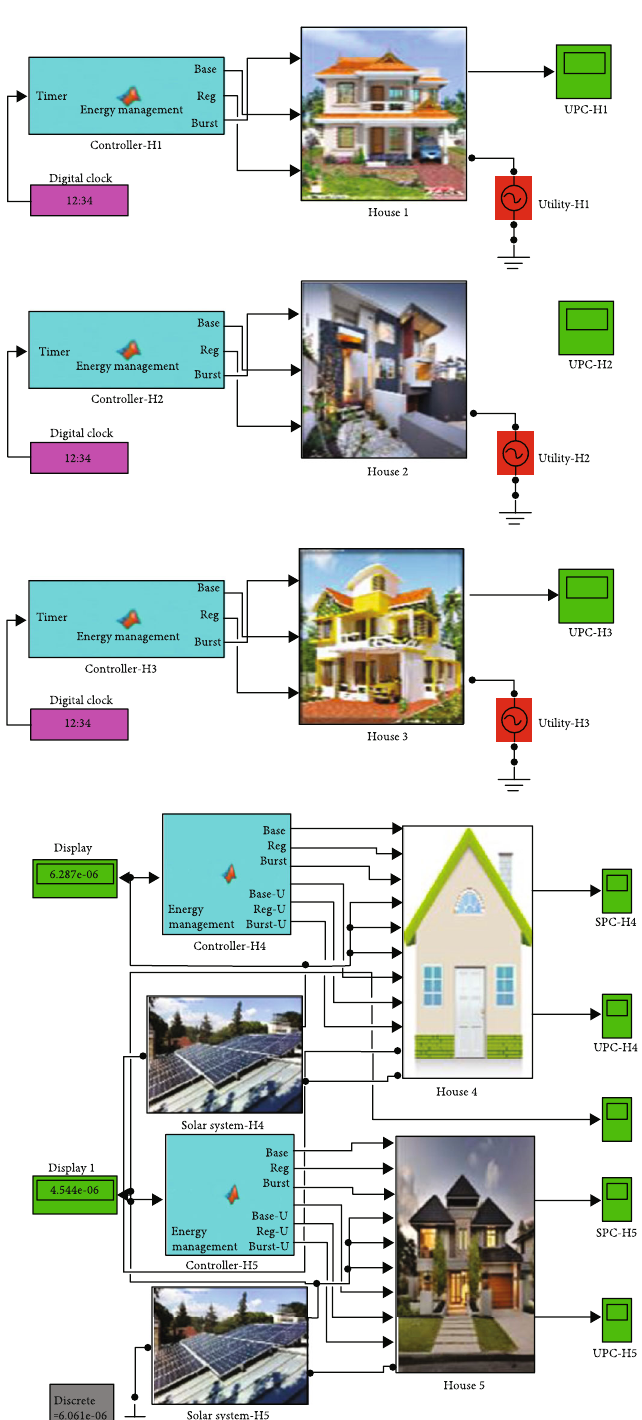
Figure 15: Proposed energy management